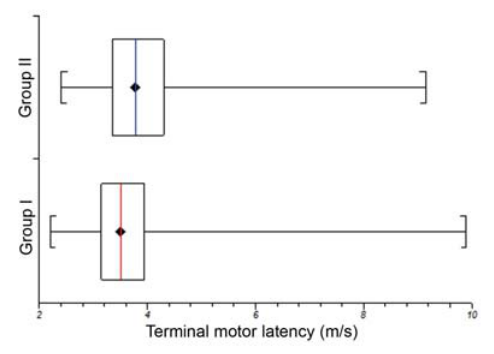
FIGURE 5. Terminal motor latency. Median value TML for Group I was 3.10 m/s, and Group II 3.38 m/s. The difference was statistically signi fi cant (p<0.001).